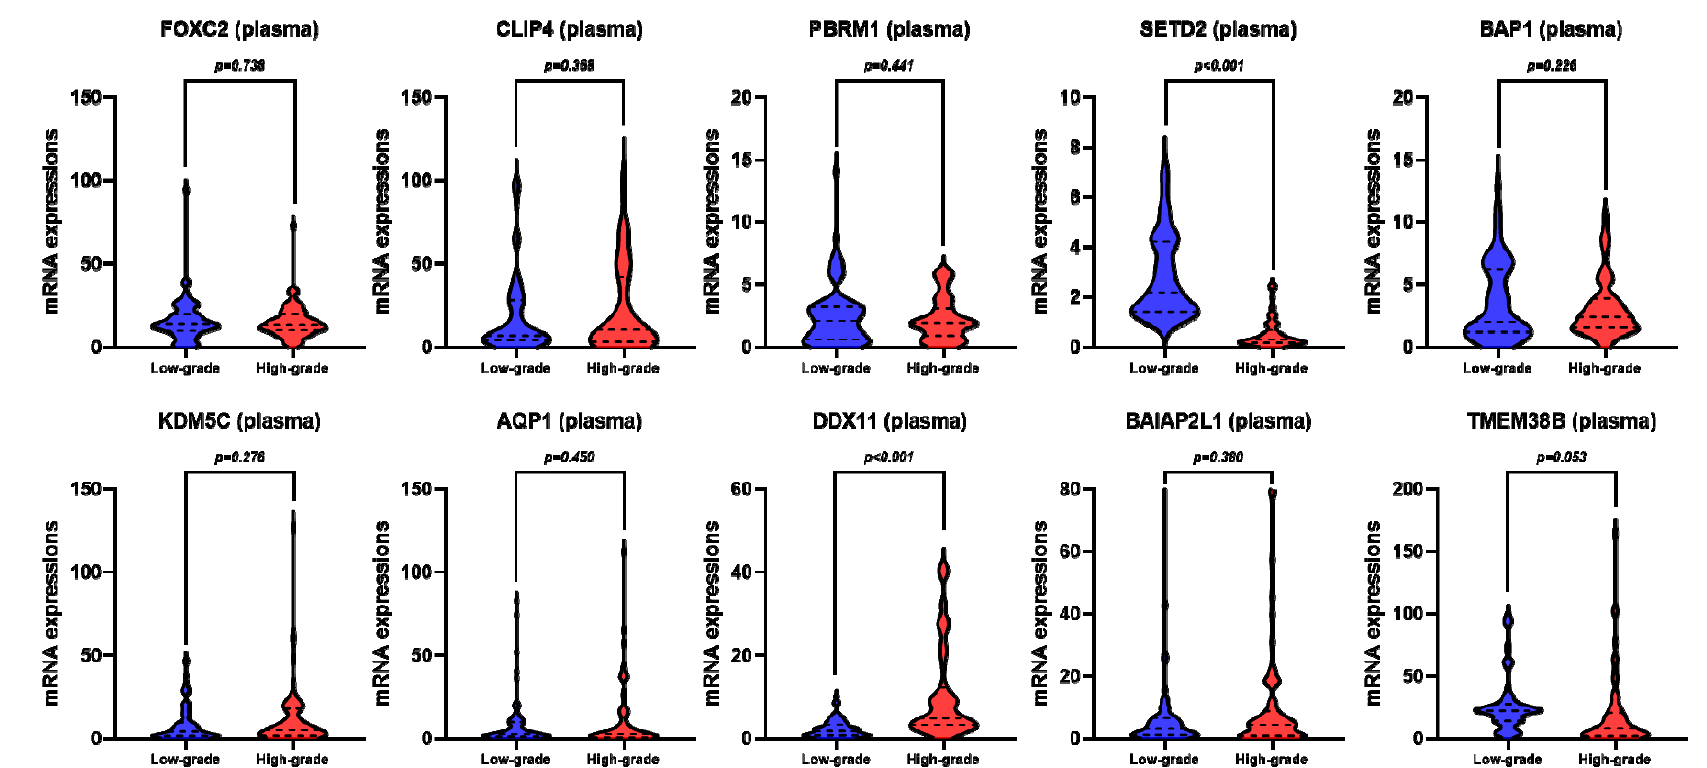
Figure 2. mRNA levels of target genes in low-grade vs. high-grade clear cell renal cell carcinoma (ccRCC): ( a ) frozen tissue; ( b ) plasma.